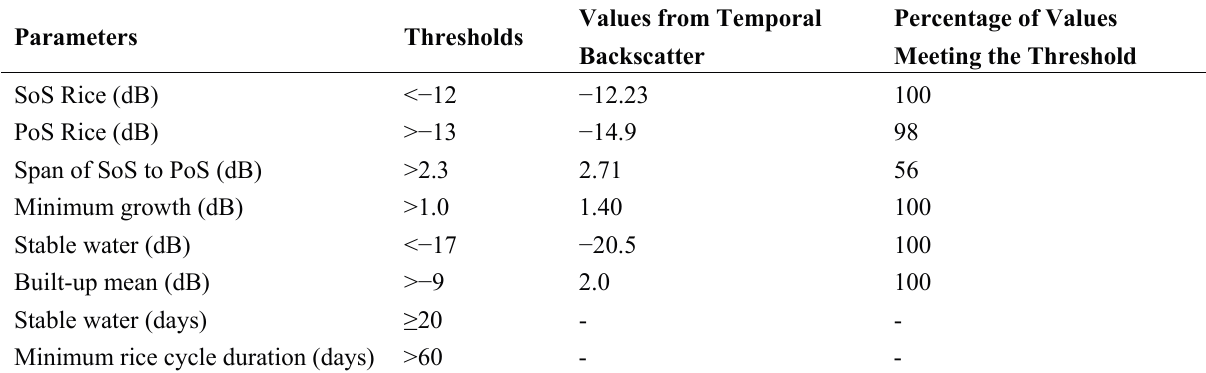
Table 7. Thresholds selected for rice identification and flooding/transplanting dates using CSK multitemporal images.